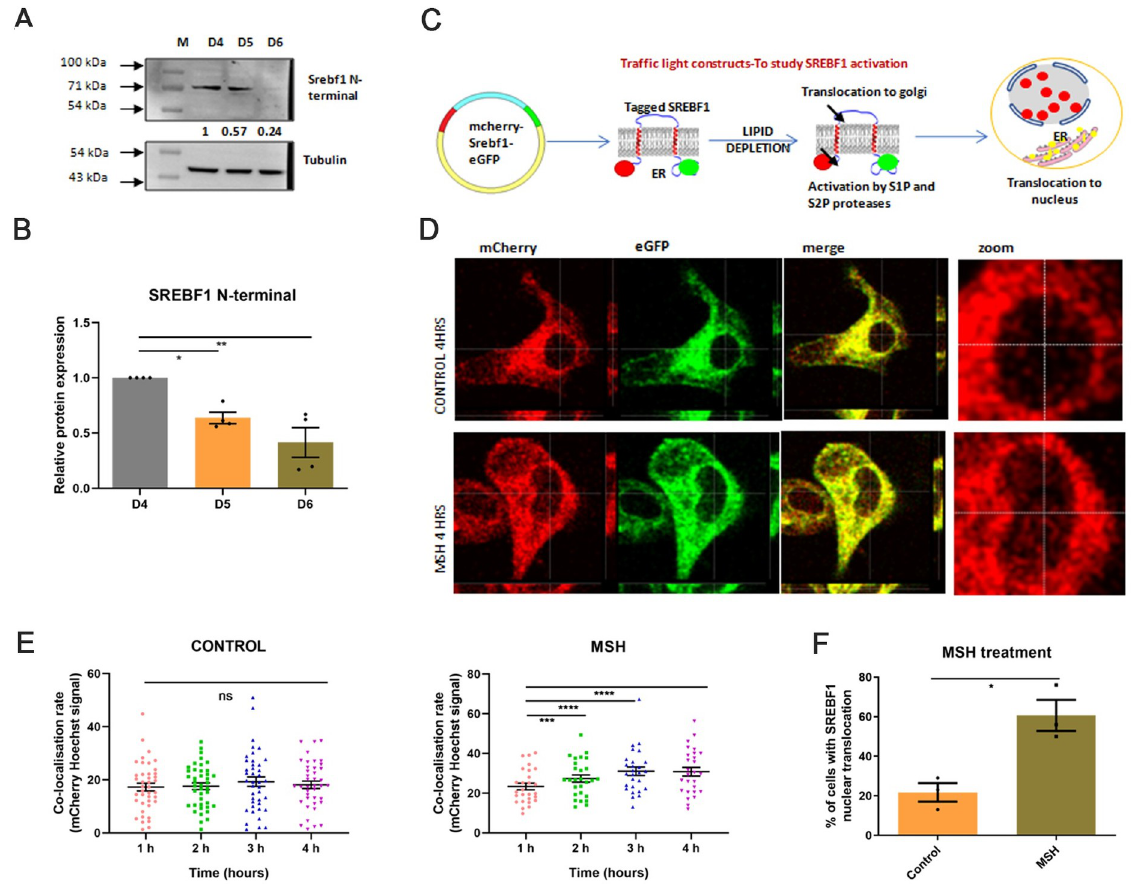
Fig 5. Melanogenesis induction causes activation of SREBF1. (A) Representative western blot showing SREBF1 N-terminal levels on different days of pigmentation, normalized to tubulin ( N = 4). Numerical values show average fold change for 4 biological replicates. ( B) Bar graph depicting quantitative fold change of Srebf1 N-terminal expression with respect to D4. Mean ± SEM is plotted for 4 biological replicates. One-way ANOVA is applied, F (2,9) = 12.71, p -value = 0.0024. ( C) Schematic design for studying SREBF1 activation using traffic light mCherry-Srebf1-eGFP vector and analyzing localization in different cellular compartments. Full-length protein localized in ER and gives yellow signal due to colocalization of mCherry and eGFP fluorescence. Cleaved SREBF1 N-terminal is transported to the nucleus along with mCherry tag, thus, accumulation of mCherry signal in the nucleus is indicative of SREBF1 activation. ( D) Representative fluorescence images showing mCherry, eGFP, and merge signal. Magnified nuclear images were shown to focus on SREBF1 nuclear translocation after 4 hours of MSH treatment. DMSO is taken as vehicle control. ( E) Dot plot depicts colocalization rate between mCherry and Hoechst signal analyzed for each cell at 1 to 4 hours, for control and MSH treatment. Around 20 to 30 cells were analyzed in each of the 3 biological replicates. One-way ANOVA is applied. For DMSO, F(2.512,99.63) = 0.9264, p -value = 0.4175, for MSH F(2,668,39.36) = 15.14, p - value < 0.0001. Dunnett’s multiple comparison test is performed for pairwise analysis. ���� p -Value < 0.0001, ��� p -value < 0.0009. ns is nonsignificant. ( F) Bar graph depicting the quantitation of number of cells showing positive phenotype after MSH treatment, determined by increased colocalization rate of mCherry and Hoechst signal from 1 to 4 hours. Mean ± SEM is plotted for combined analysis. Two-tailed Student t test is performed, t = 4.267, df = 4 p -value = 0.0130. Quantitative data are provided in S1 Data for Panels B, E, and